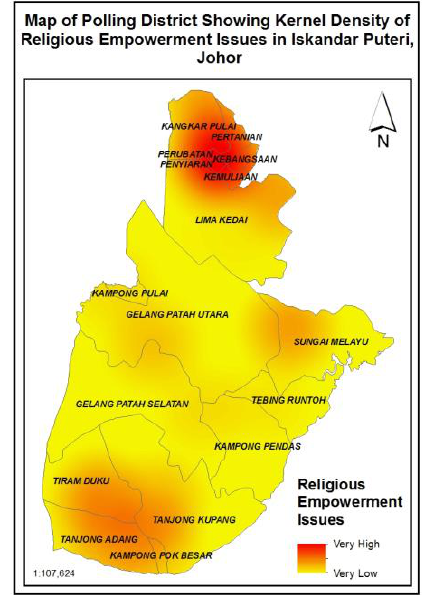
Figure 18. Result of the hot spot maps using KDA for religious empowerment issues